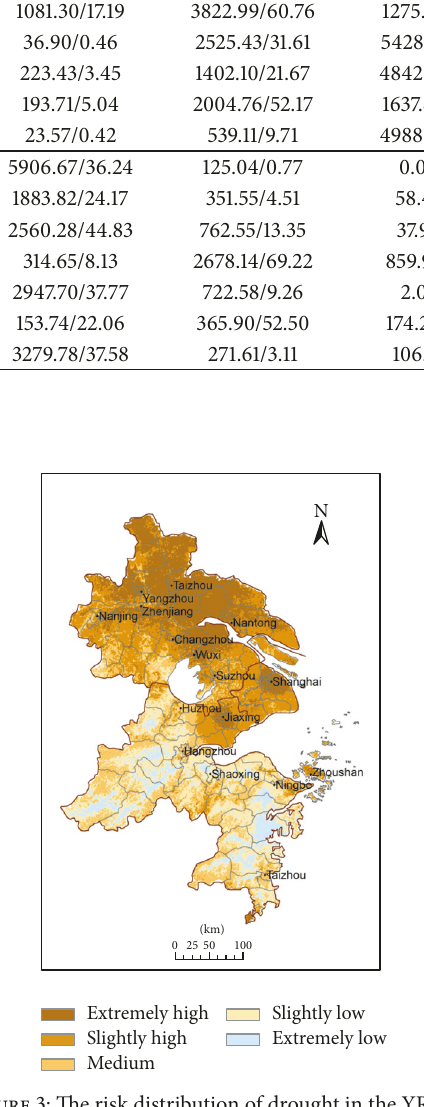
Figure 2: Distribution of drought vulnerability grades in the YRDR. Figure 3: The risk distribution of drought in the